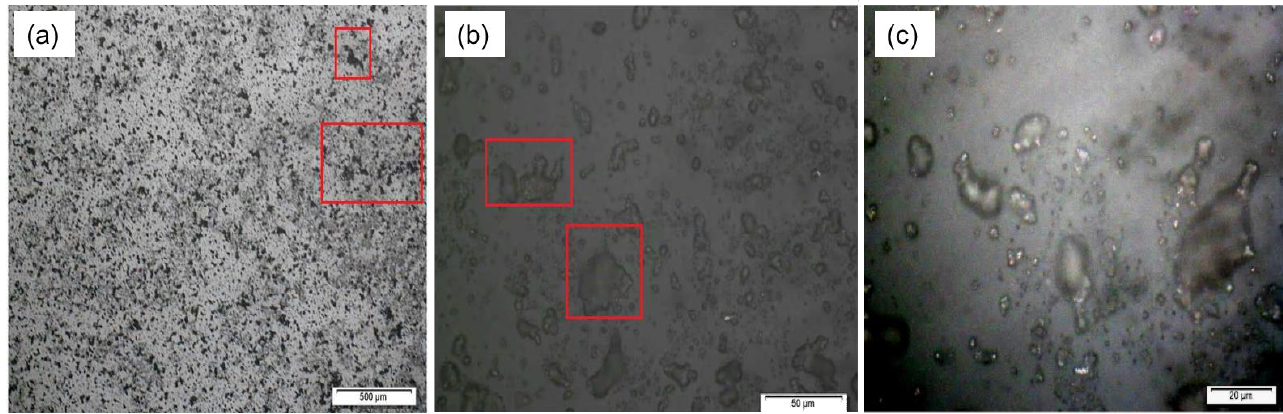
Figure 7. ( a – c ) Stereomicrographs with different magnifications of the fabricated thin-film.